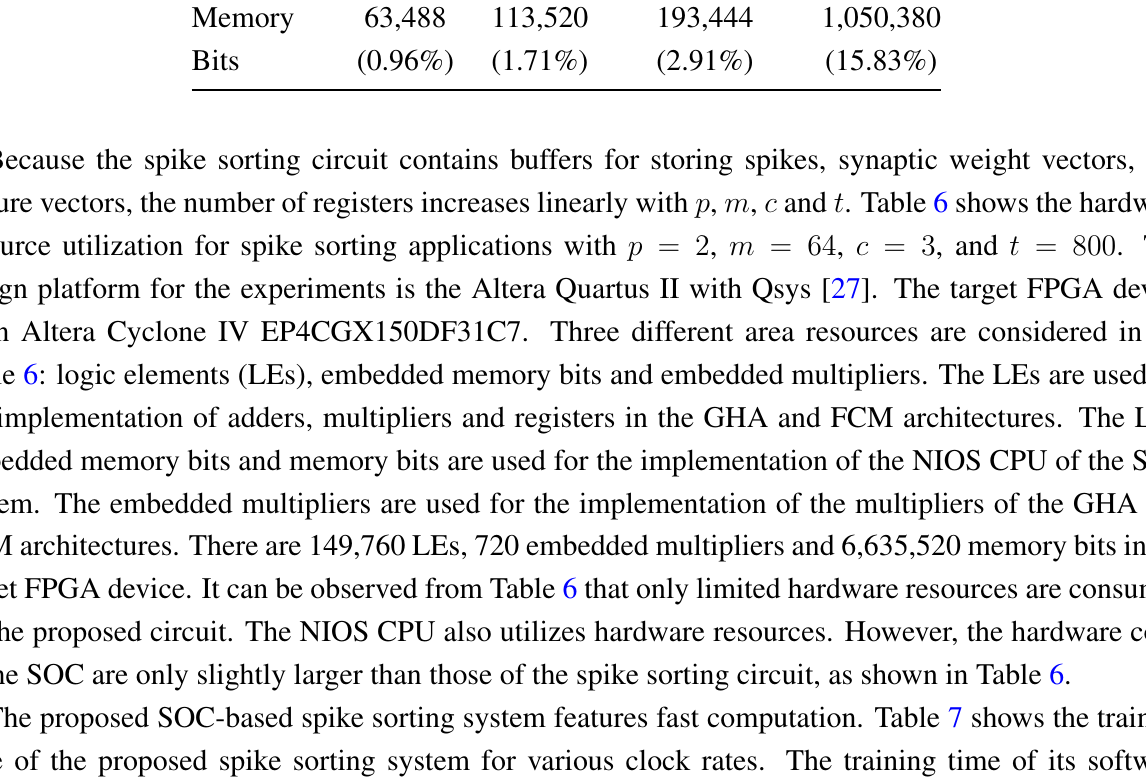
Table 6: logic elements (LEs), embedded memory bits and embedded multipliers. The LEs are used